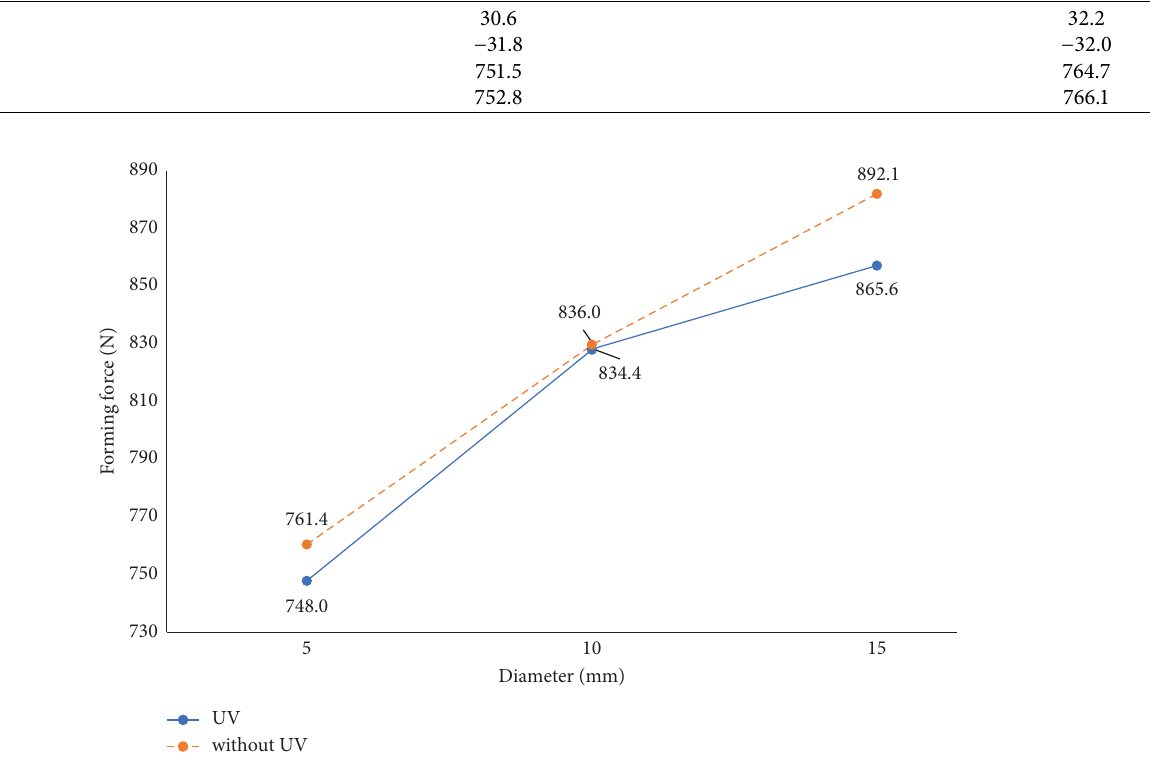
Figure 10: Forming force in the simulation of the truncated pyramid with and without UV. Table 2: Average forming forces in the simulation of the truncated pyramid. With UV